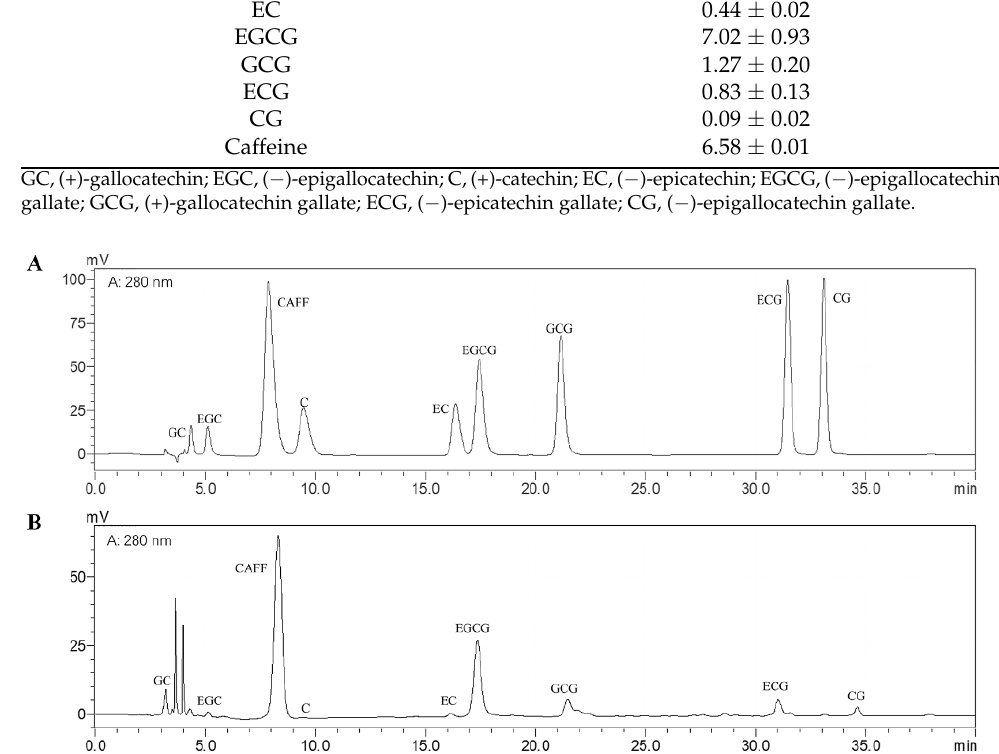
Table 2. Chemical analysis of the matcha sample.